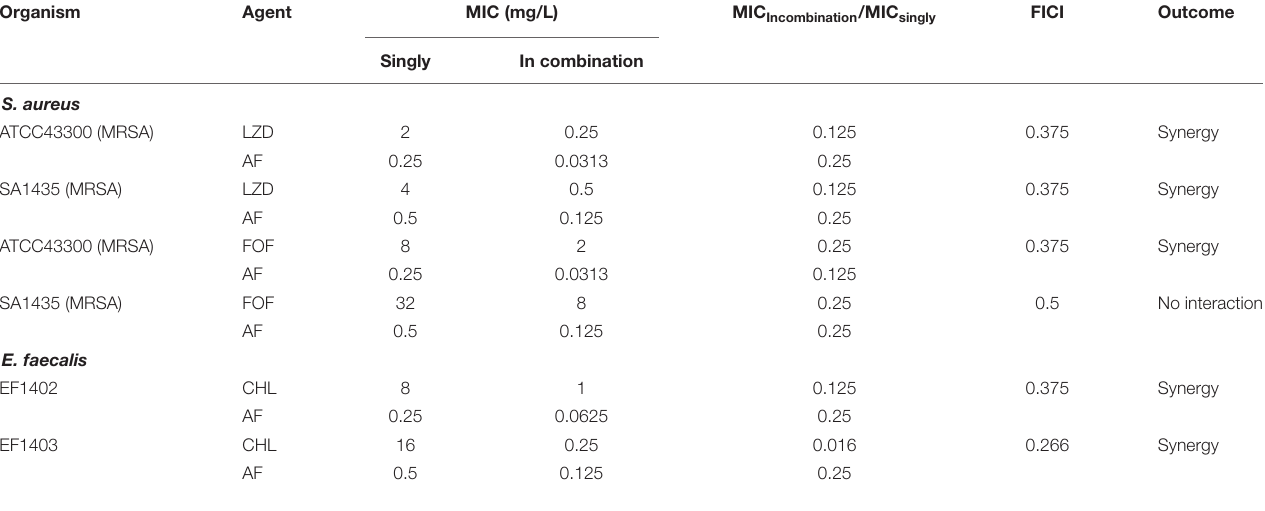
TABLE 3 | The antibacterial activity and combined effects of AF and selected antibiotics alone or in combination against MRSA and other clinical isolates. Organism